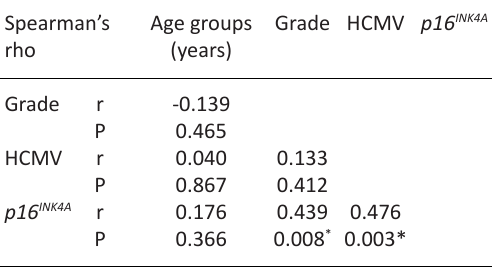
Table 4 . Spearman’s Rho Statistical Testing of Age, Grade, Hcmv-CISH And P16 ink4a -IHC To Evaluate The Studied Markers In Oral Squamous Cell Tissues Spearman’s